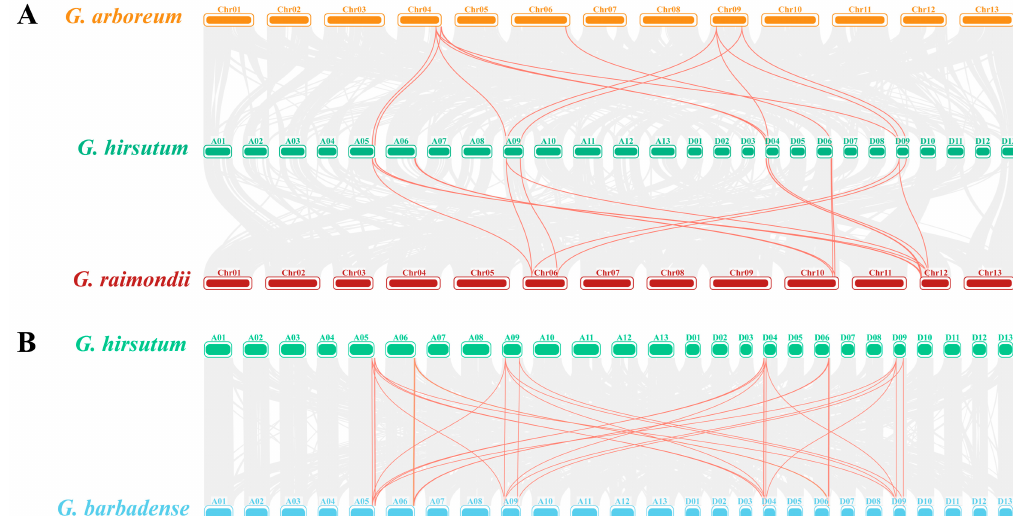
Figure 3. Collinearity analysis. The grey lines in the background represent the collinearity of the entire genome and the red lines represent gene pairs in the GPDH family. Chromosomes of different cotton species are represented by different colors. ( A ) The collinearity between G. hirsutum and two diploid cotton species. ( B ) The collinearity between G. hirsutum and G. barbadense .